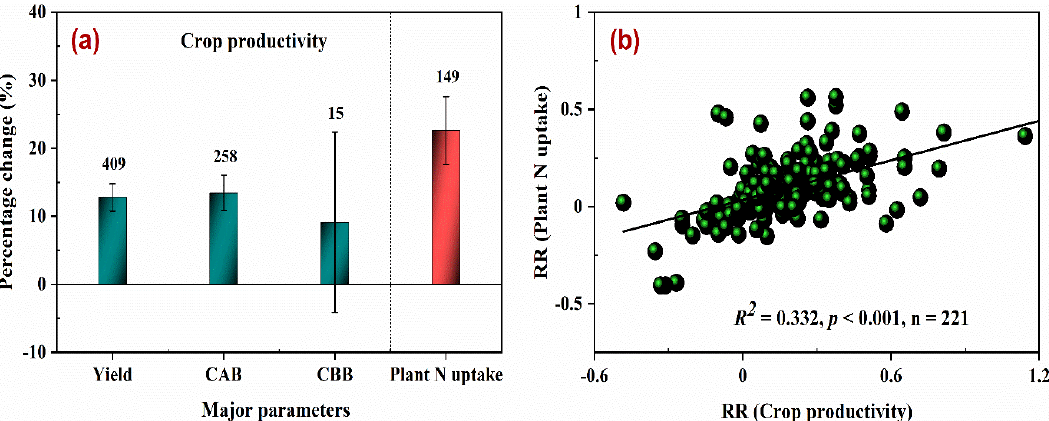
Figure 2. Means and 95% confidence intervals of the percentage changes (%) of biochar effects on ( a ) plant (crop) N uptake and crop productivity including crop yield (Yield), crop aboveground biomass (CAB), and crop belowground biomass (CBB); the sample size of each variable is displayed over the corresponding bar. ( b ) Relationships between the response ratios of crop productivity vs. plant (crop) N